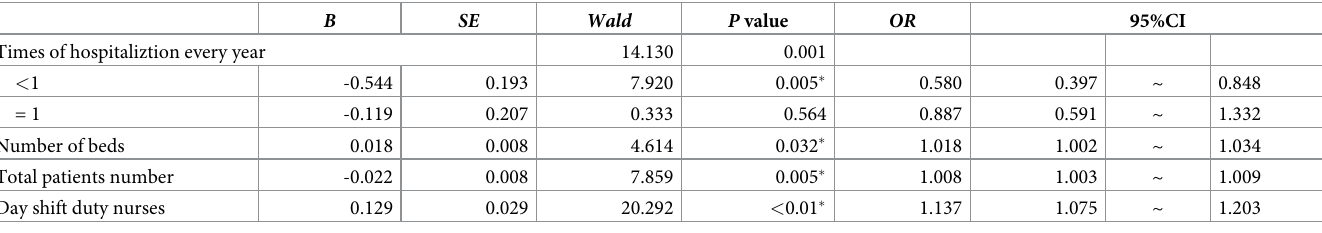
Table 5. Risk factors for patients’ favorite nurse with good health education